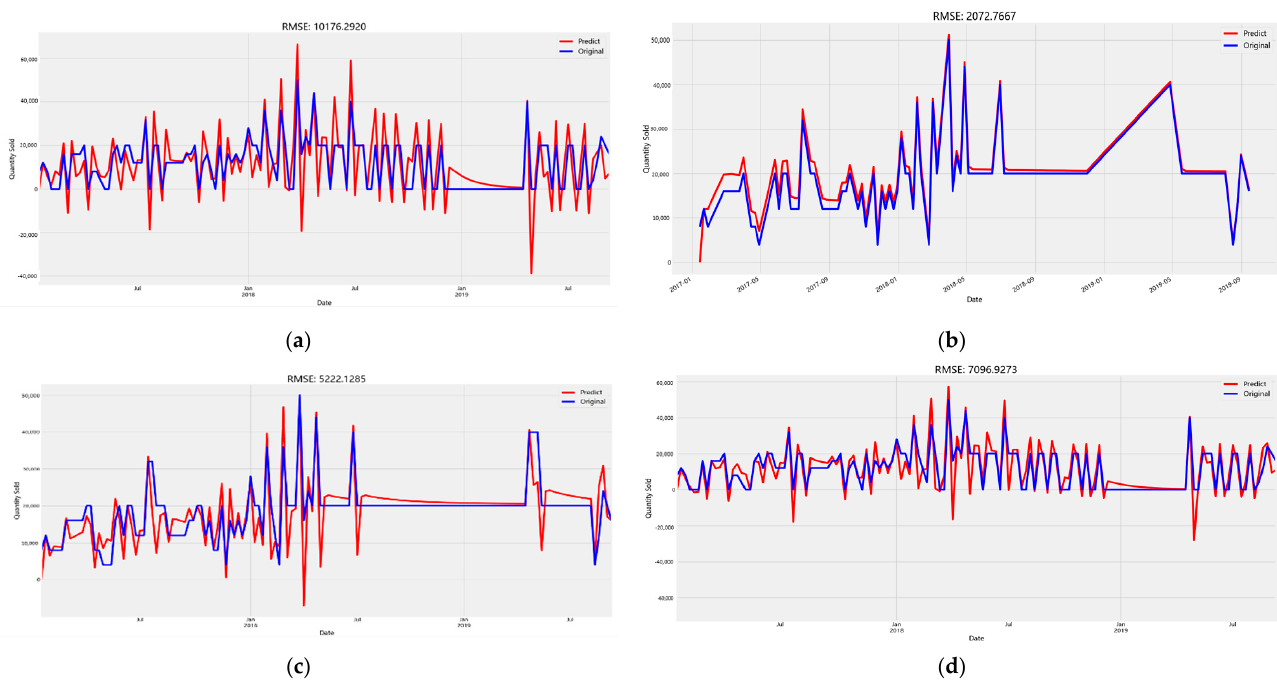
Figure 4. Average square root error assessment graph for empty value processing. ( a ) Retaining the original data; ( b ) deleting the null value; ( c ) replacing the null value with the high-frequency technique; ( d ) replacing the null value with the average value.